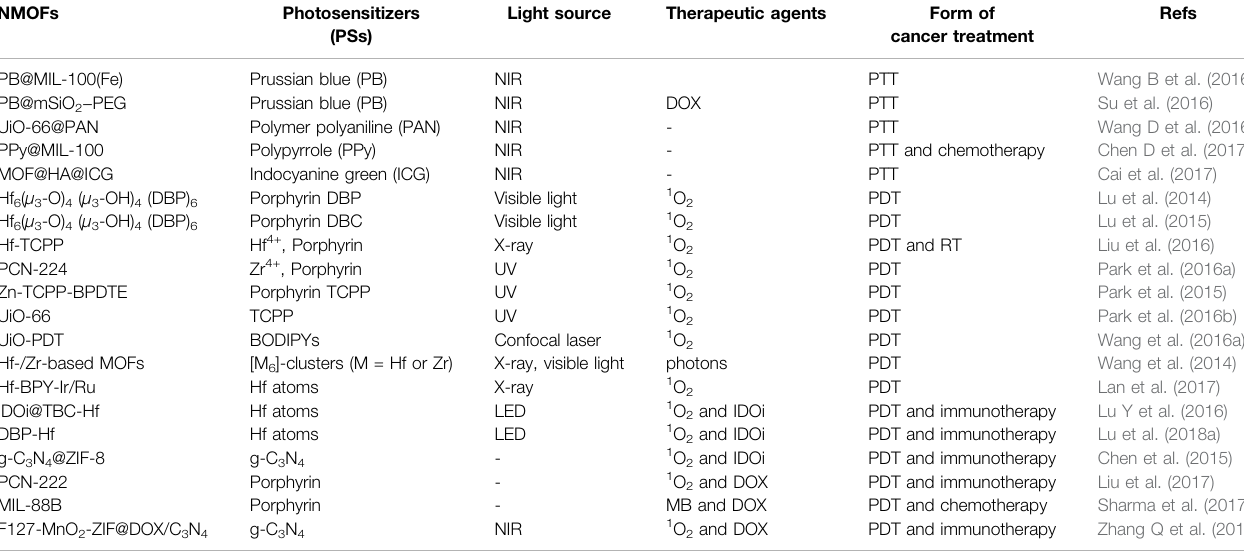
TABLE 2 | The form of cancer treatment of various NMOFs as phototherapeutic agents for cancer therapy. NMOFs Photosensitizers